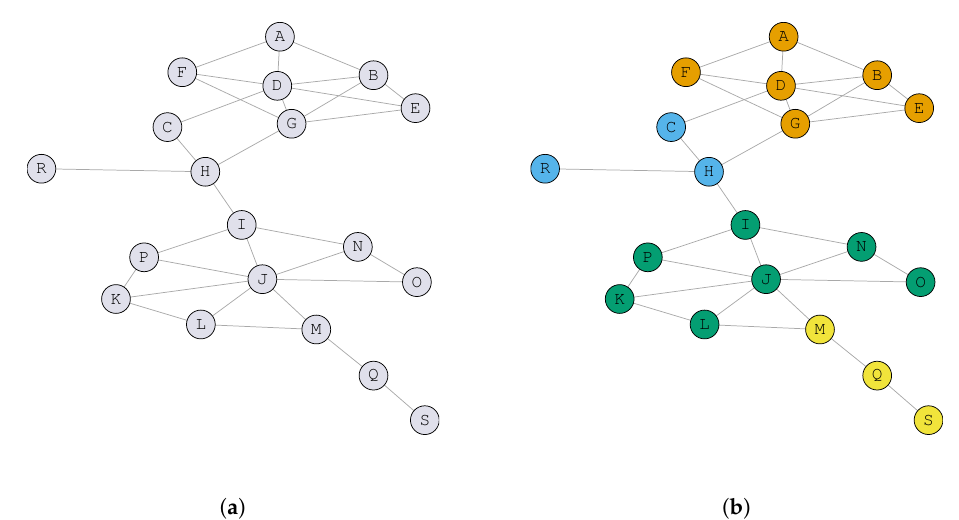
Figure 1. ( a ) example of a graph derived from a social network and ( b ) a possible solution for the community detection (each community is represented with a different color).